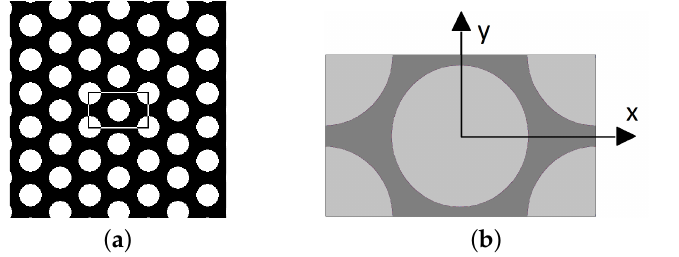
Figure 3. ( a ) Hexagonal arrangement of unidirectional fibers in yarn transverse direction (computa- tionally generated image), ( b ) PHA